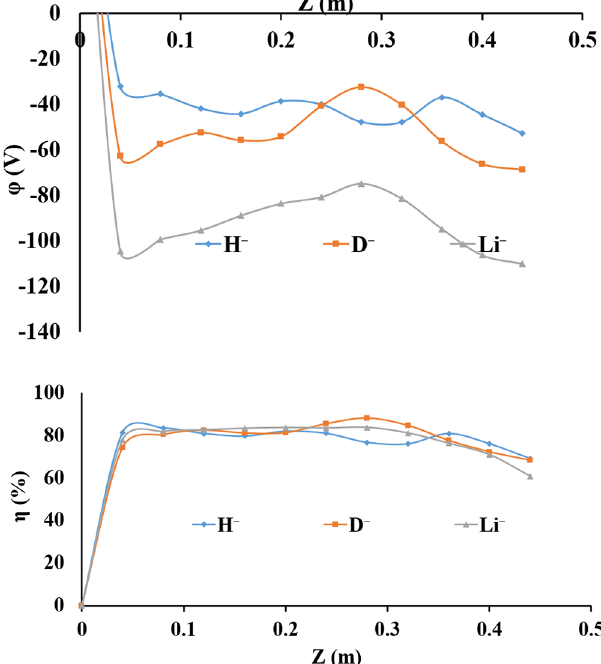
FIG. 7. Beam potential along the line for 30 mA of H − , D − , and Li − beams (top) and compensation levels for the same ion beams (bottom).